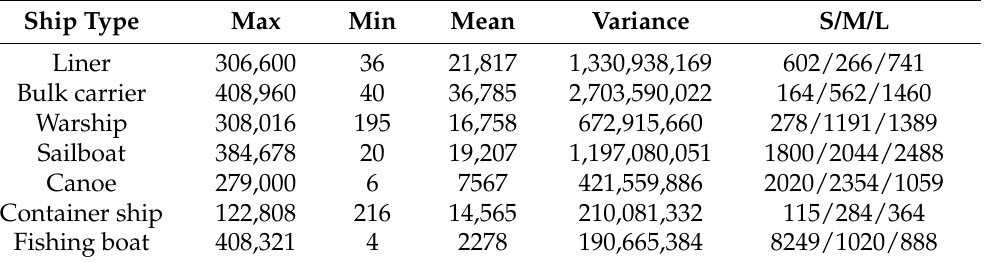
Figure 8. Data set distribution: The gray bar chart represents the number distribution of images for each type of ship; The blue bar chart represents the number distribution of each type of ship. Table 3. The size distribution of the targets. The max, min, mean variance and S/M/L, respectively, represent the maximum area, the minimum area, the mean value of the area, the variance of the area and the number of small, medium and large targets in one class of ships.